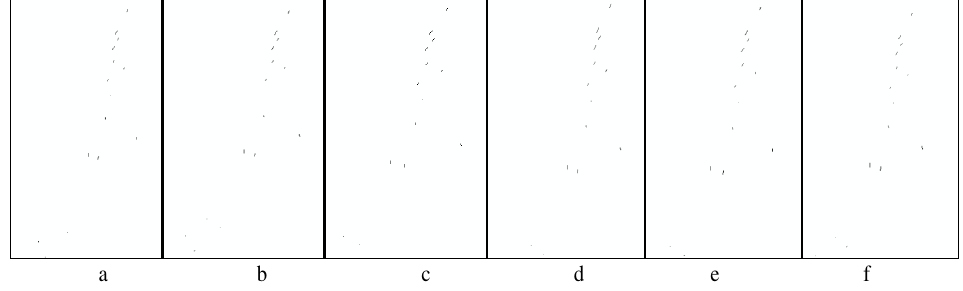
Figure 6. Vector Plot Error for Easting and Northing Coordinates based on Different GCP